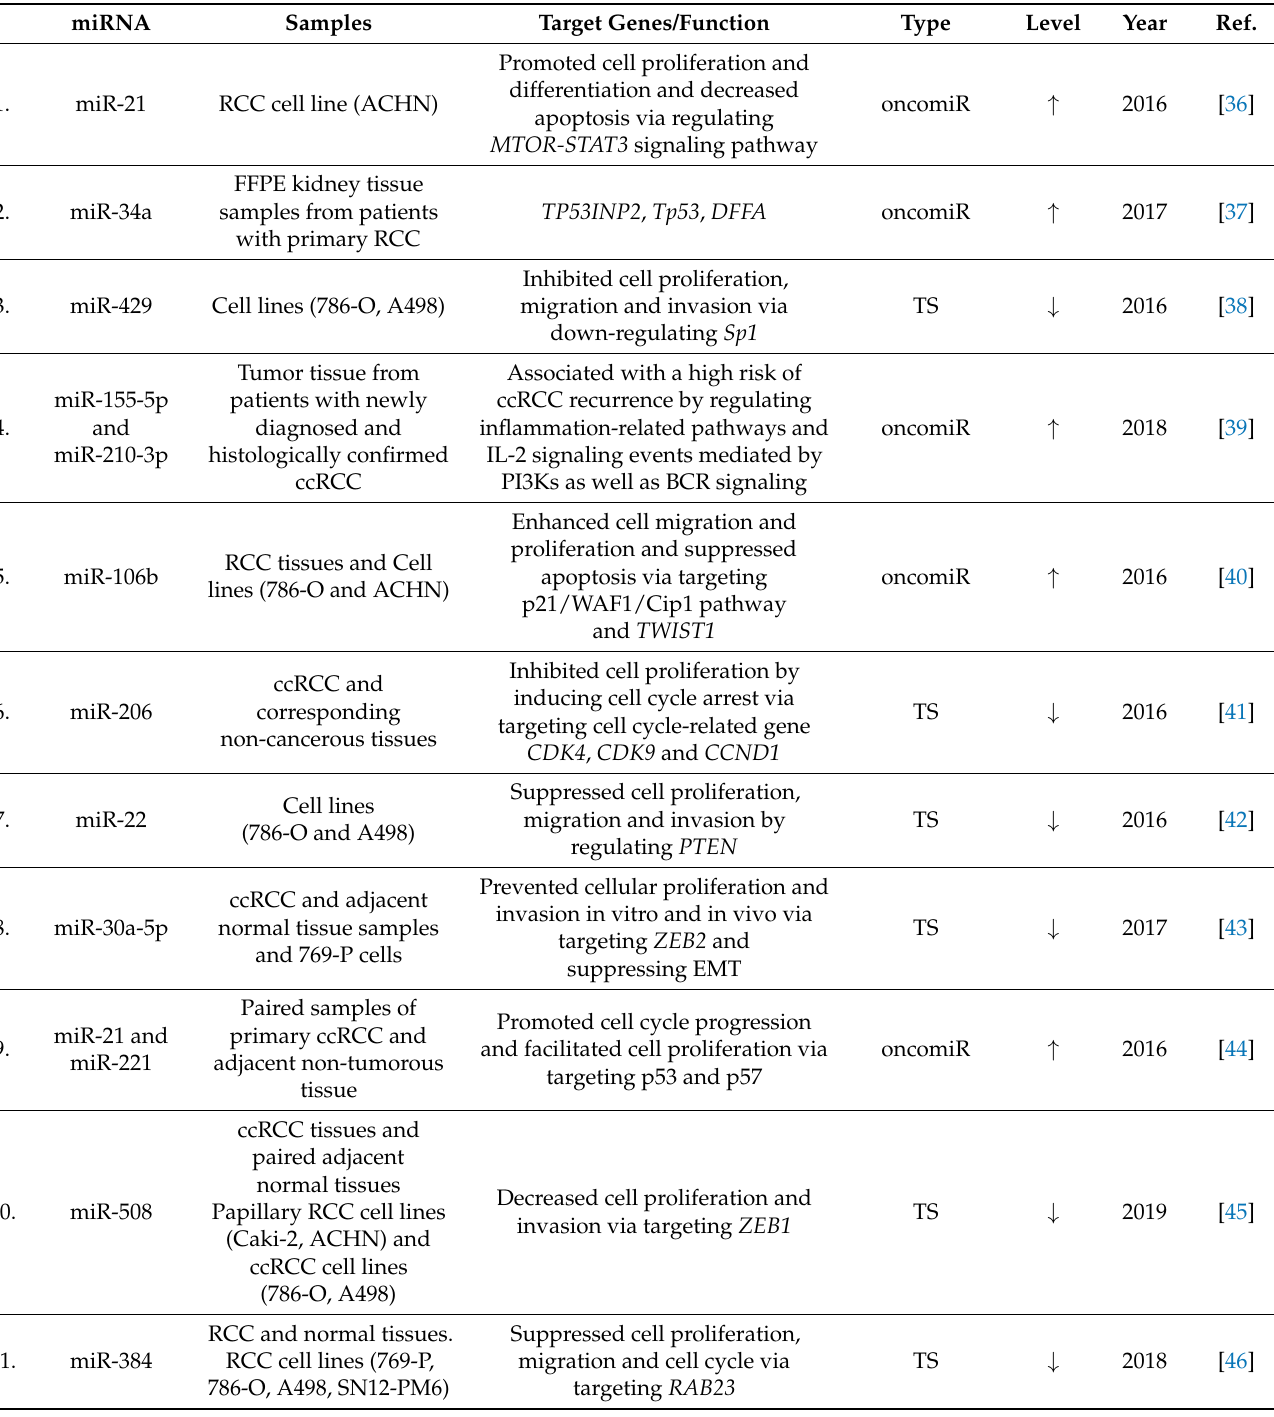
Table 1. miRNAs acting as oncomiRs or tumor suppressor genes in addition to their biological roles and possible targets in kidney cancer. miRNAs are arranged numerically based on being most relevant and frequently attributed in the literature.